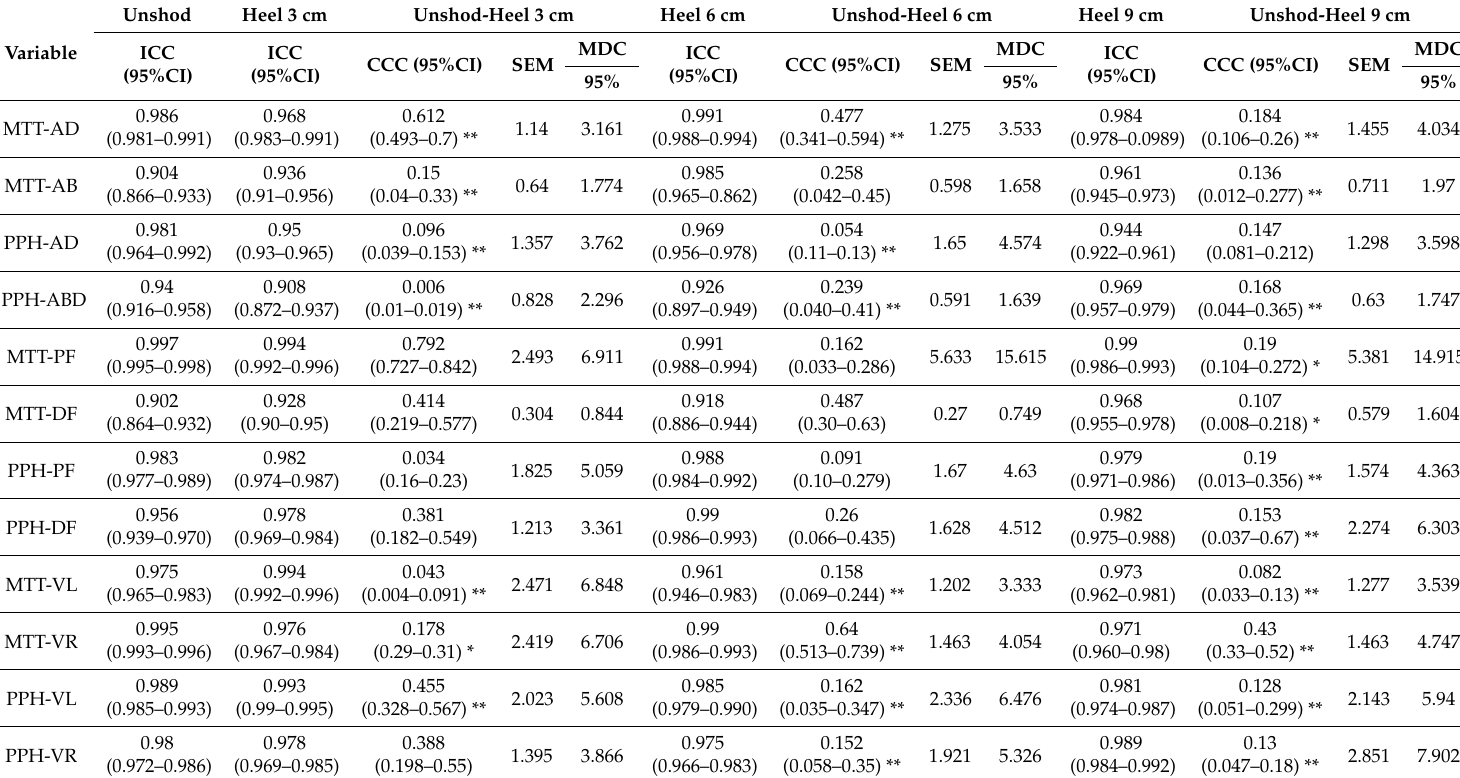
Table 2. Reliability ICC and CCC of static variables in unshod versus heels that were 3 cm, 6 cm, or 9 cm